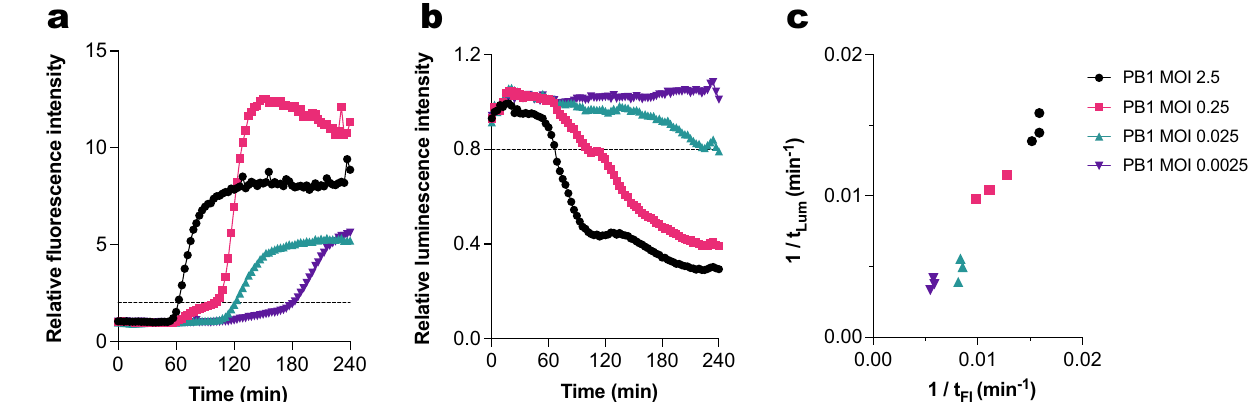
Figure 3. The fluorescent DNA dye signal correlates with a loss of bacterial metabolic activity. PAO1 expressing a luciferase reporter system was incubated with phage PB1 (different MOIs) at 37 °C in the presence of Sytox green. ( a ) Sytox green fluorescence intensity was measured using a fluorometer. Values were divided by the control signal (uninfected bacteria) to obtain relative fluorescence intensity. Black dotted line represents the threshold for phage-mediated damage (relative fluorescence = 2). ( b ) Luminescence intensity of samples was measured and divided by the signal of the control. Black dotted line represents threshold for phage-mediated damage (relative luminescence = 0.8). ( c ) Correlation between time to reach phage-mediated damage threshold as determined through fluorescent DNA dye staining and luminescence measurements for phage PB1 at different MOIs (Pearson’s r = 0.97, two-tailed P value < 0.0001). Data are represented as 1/t, where higher values indicate a faster infection. Data points represent individual results of three independent experiments. ( a , b ) A representative graph of at least three independent experiments is